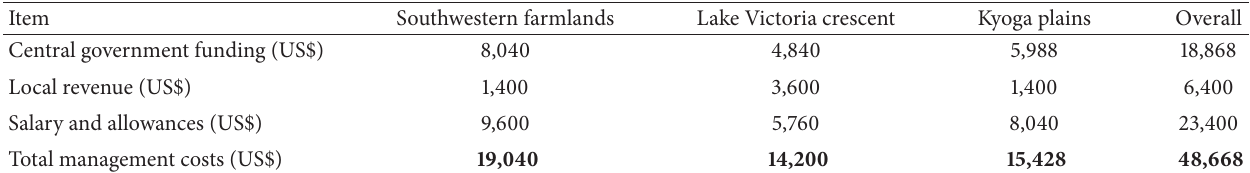
Table 13: Costs for wetland management and conservation in three agro-ecological zones of Uganda (Data for